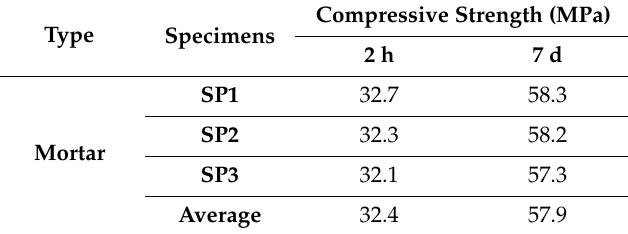
Table 3. Compressive strength of